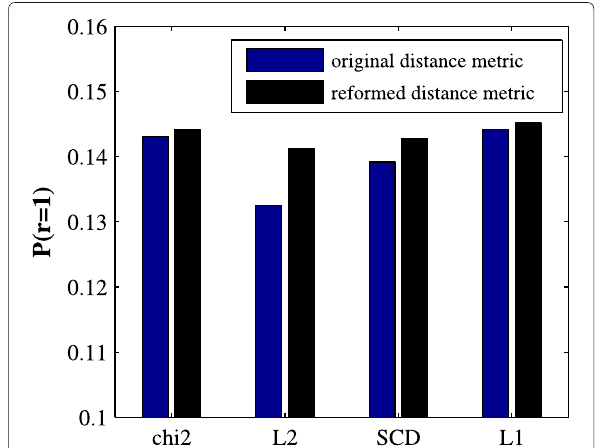
Fig. 5 Coherence distribution of ULBP